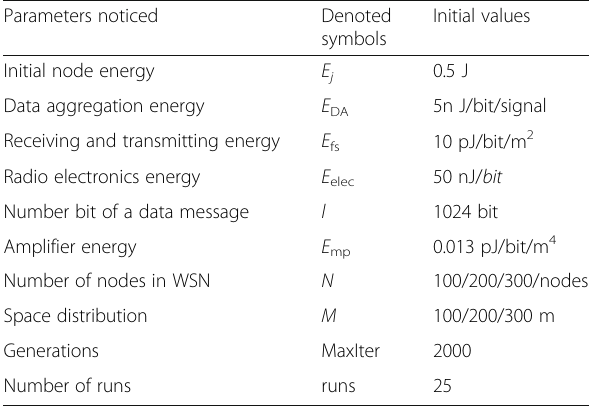
Table 1 Initial values for setting parameters of the experiment